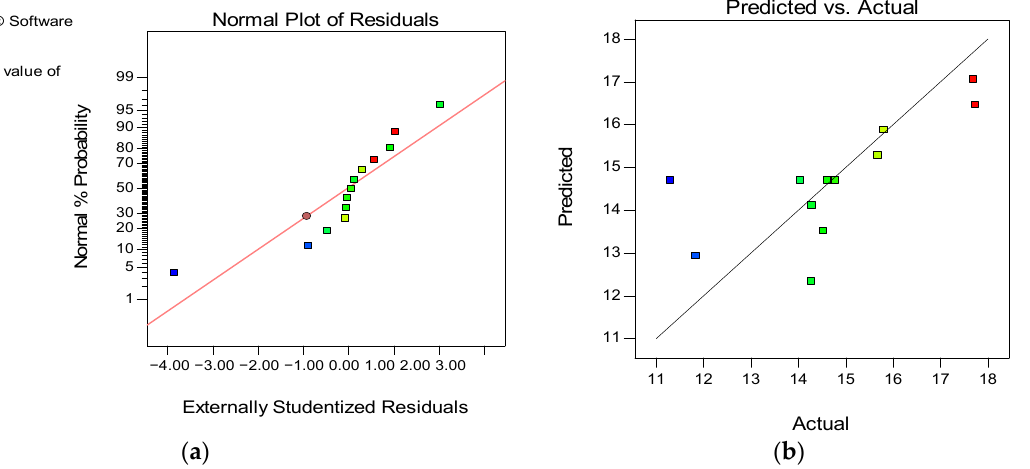
Figure 17. ( a ) The normal plot of residuals and ( b ) actual versus predicted plot for the OBA-RECC ME model.